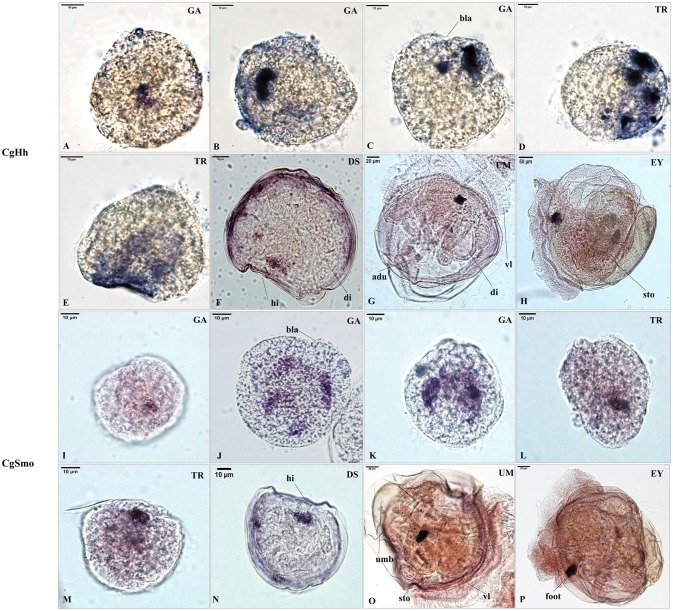
RNA localization patterns of key hedgehog pathway genes during embryonic to larval stage. (A–C) RNA localization patterns of CgHh during gastrula stages. (D,E) RNA localization patterns of CgHh during trochopore stages. (F) RNA localization patterns of CgHh during D-shaped stages. (G) RNA localization patterns of CgHh during umbo stages. (H) RNA localization patterns of CgHh during eyed stages. (I–K) RNA localization patterns of CgSmo during gastrula stages. (L,M) RNA localization patterns of CgSmo during trochopore stages. (N) RNA localization patterns of CgSmo during D-shaped stages. (O) RNA localization patterns of CgSmo during umbo stages. (P) RNA localization patterns of CgSmo during eyed stages. GA, gastrulae stage; TR, trochophore stage; DS, D-shaped stage; UM, umbo larvae stage; EY, eyed-larvae stage; bla, blastopore; hi, hinge; di, digest gland; vl, vlum; um, umbo; fo, foot; adu, adductor.